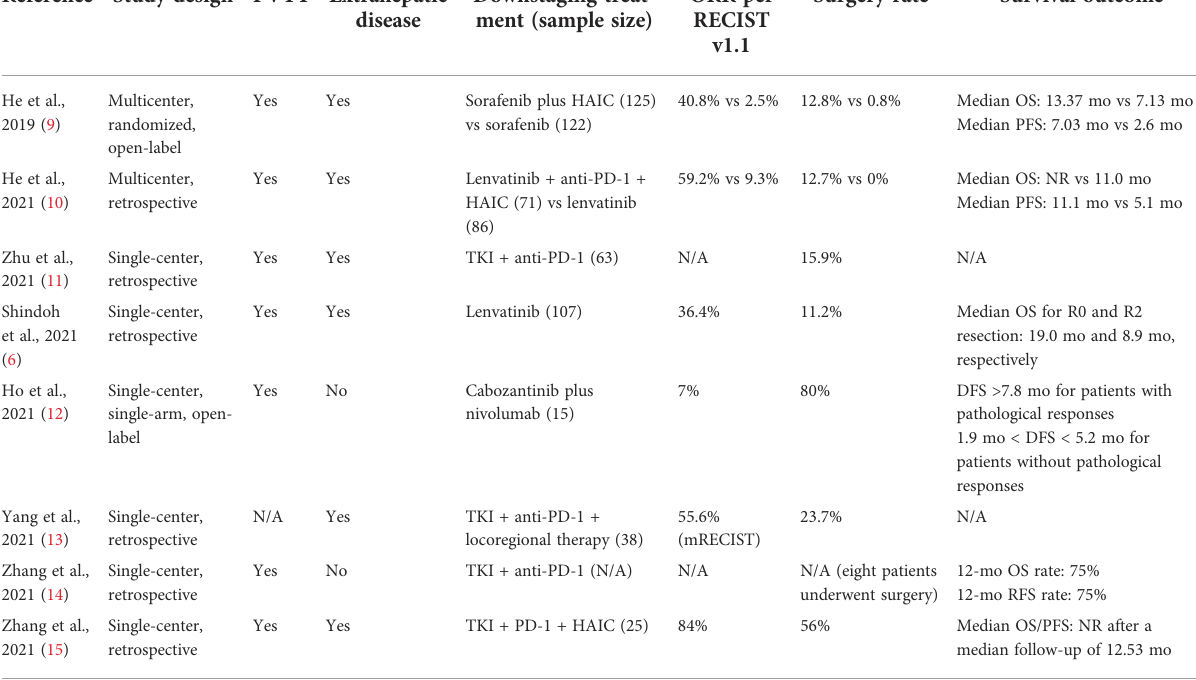
TABLE 6 Studies reporting surgery rates following systemic (± locoregional) therapy in initially unresectable HCC. Reference Study design PVTT Extrahepatic